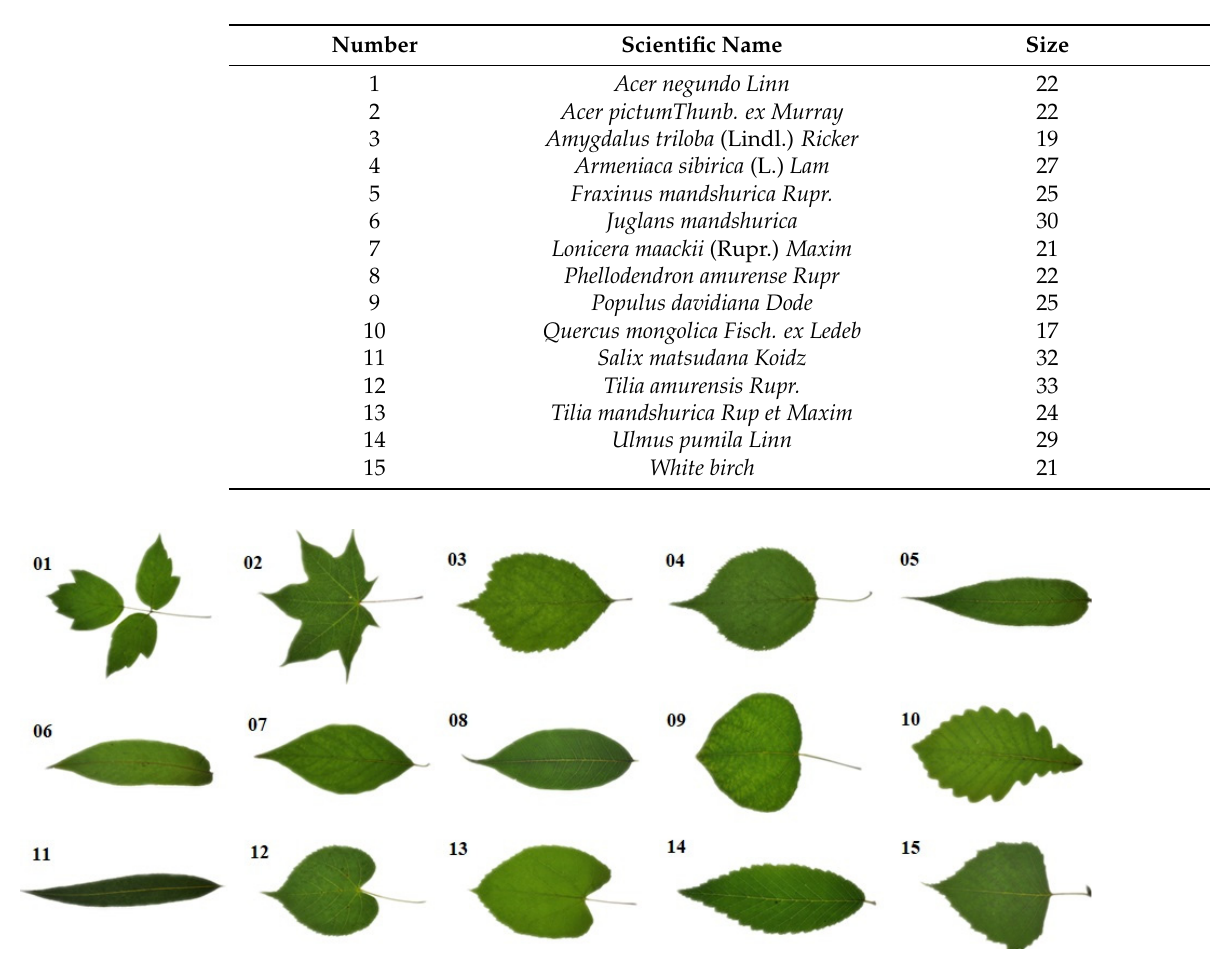
Table 1. Details of the 15 tree leaves.